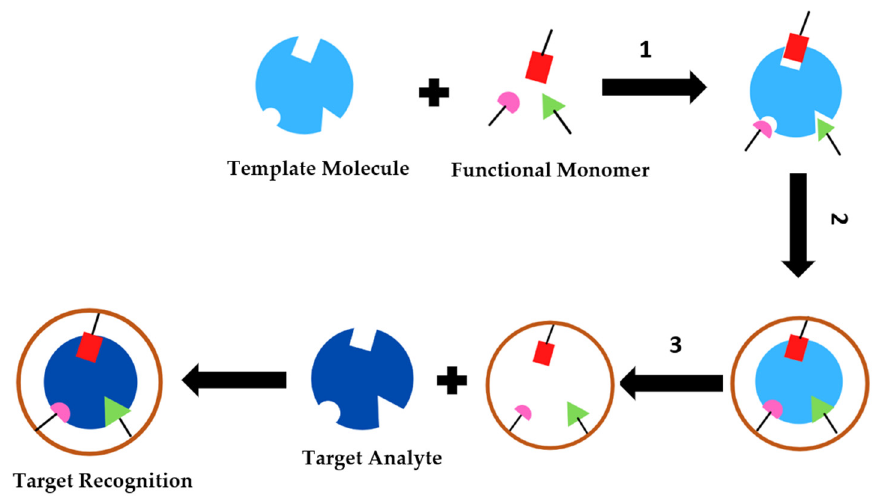
Figure 8. Schematic representation of the molecular imprinting process. 1—complexation; 2— polymerization; 3—extraction [85].